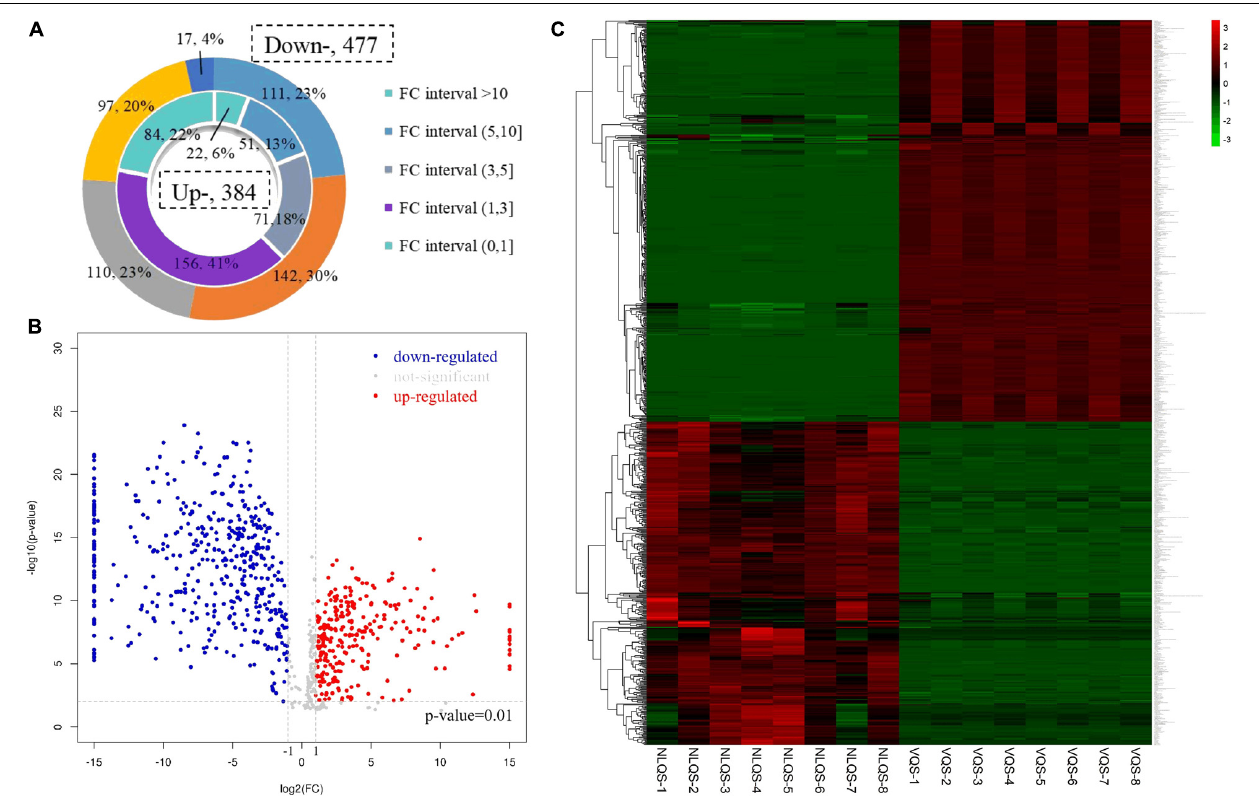
FIGURE 2 | Fold change (FC) arrangement and pattern of metabolites that were different in NLQS compared with those in VQS in the honeybee Apis mellifera . (A) The inner circle indicates high concentration metabolites, and the outer circle indicates low concentration metabolites in NLQS compared with those in VQS. (B) Volcano plot of metabolites that were different in NLQS compared with those in VQS. Each dot represents an individual metabolite: red indicates high concentration, blue indicates low concentration, and gray indicates no change. (C) Pattern heat map. The color code from green to red indicates the abundance of metabolites from low to high,